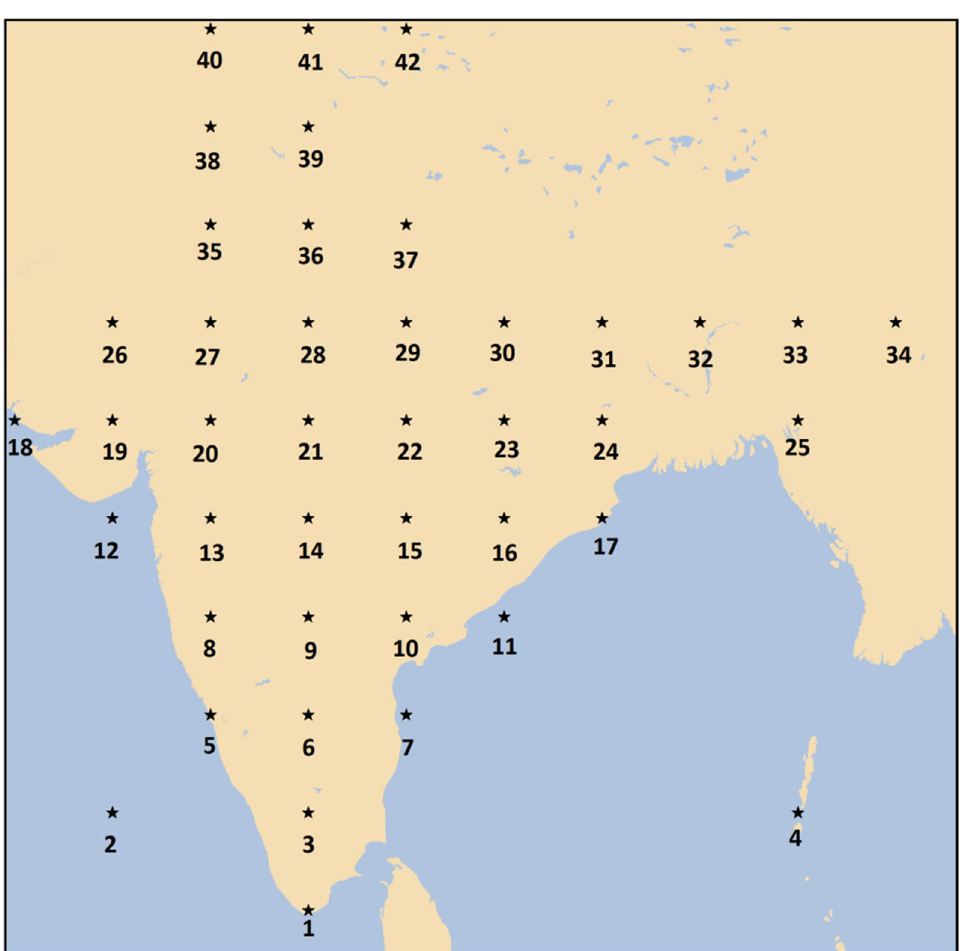
Fig. 2 Schematic figure of the study locations (black stars) with their corresponding numbers, i. Each study location is named as C ‘i’ for the